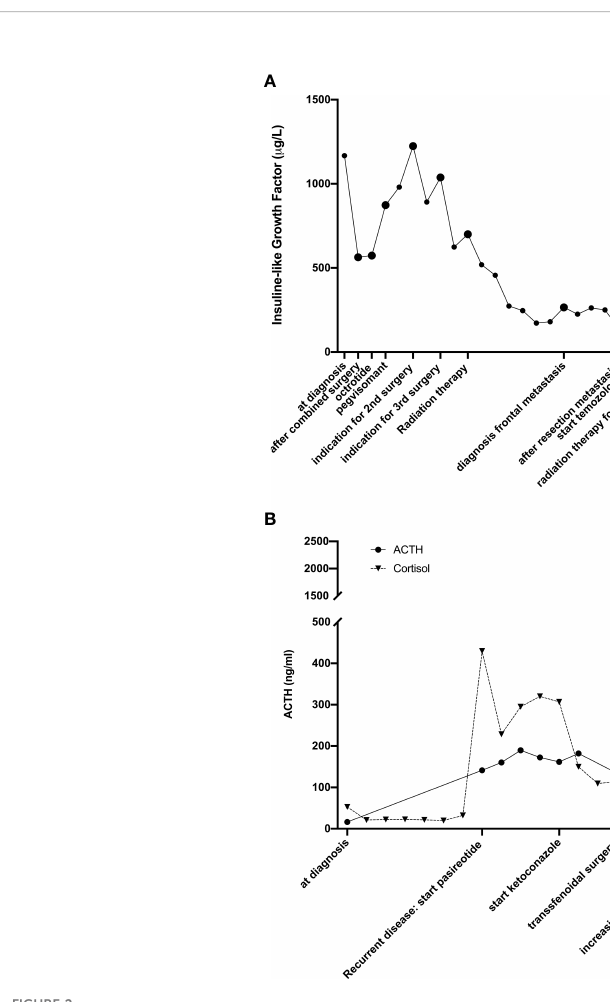
FIGURE 2 Timeline of hormonal changes in relation to the different treatments of the second (A) and fourth (B) patient.